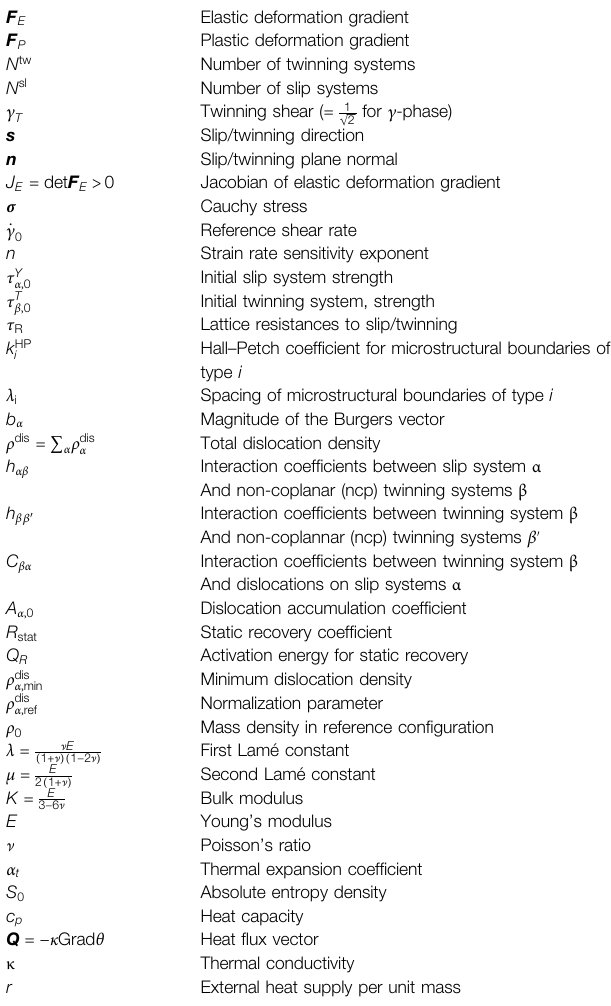
TABLE 2 | Declaration ofsymbols that are used inthe basemodel (i.e., Eqs. 9 – 28 ). F